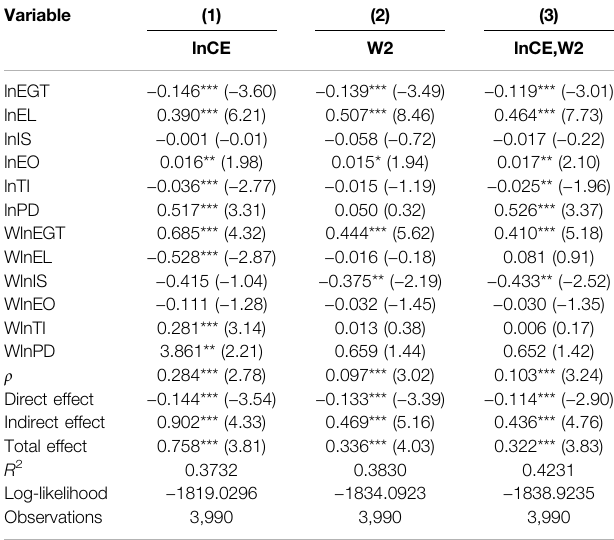
TABLE 5 | Robustness test results.